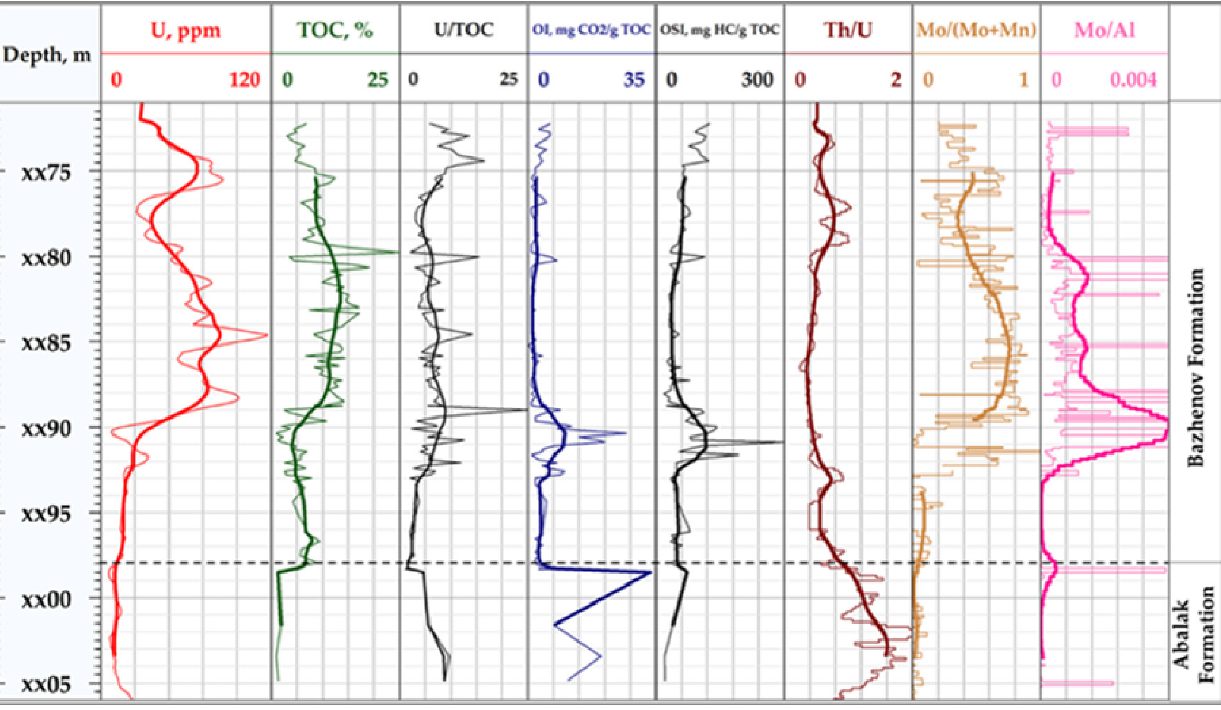
Figure 4. Cross ‐ plot of uranium and vanadium concentrations for well 1, Bazhenov Formation. Blue line corresponds to equation U = 0.03 · V − 2.05, where the correlation coefficient R = 0.87.